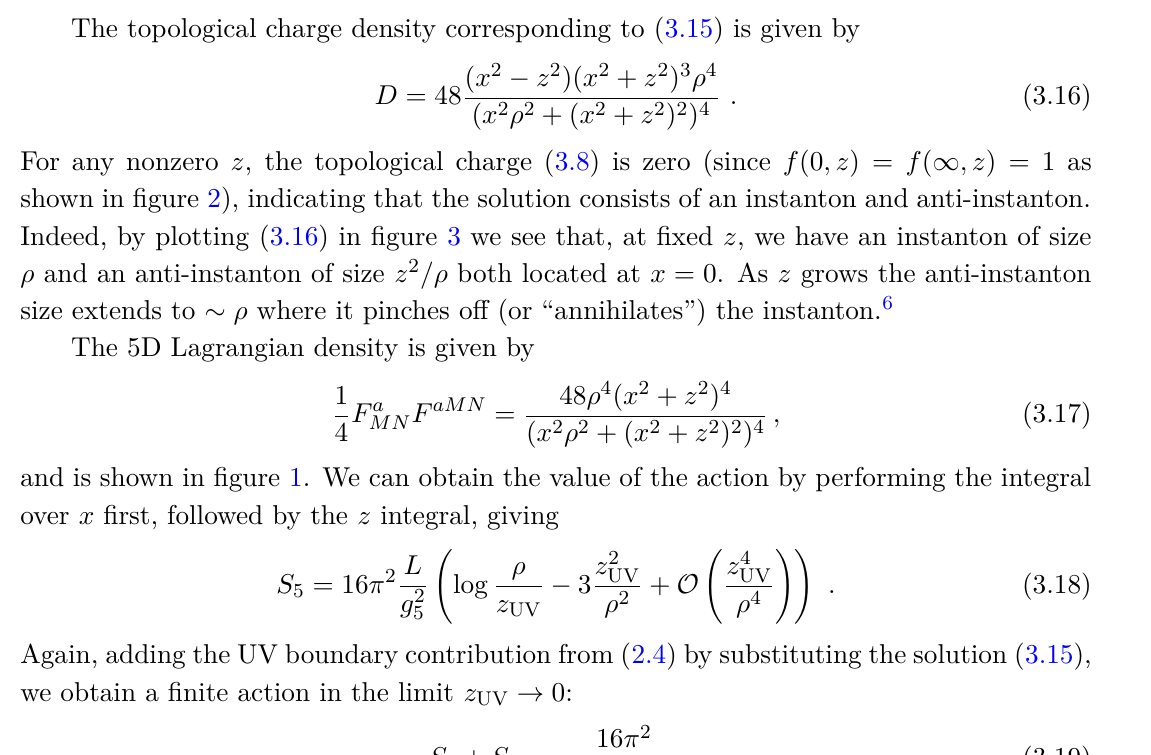
Figure 3 . Contour plots of the topological charge density (multiplied by the volume factor 2 π 2 x 4 and for ρ = 1 ) of the uplifted 4D instanton (left) and the instanton-anti-instanton (3.16) (right). In the right plot the diagonal line, x = z corresponds to zero charge density with the upper (lower) region depicting contours of negative (positive) charge density associated with the anti- instanton